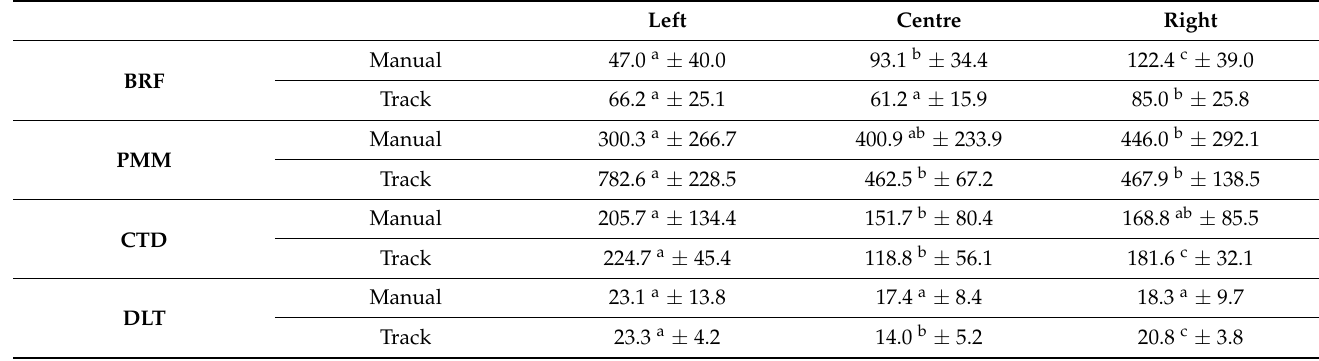
Table 4. Horizontally stratified application rates of insecticides. Manual and track spray data was classified using left, centre, and right horizontal swath positions. Median application rate ± standard deviation is indicated for each horizontal position. Comparisons are done between horizontal positions by spray method. Significant differences are indicated by different lower-case letters. Left